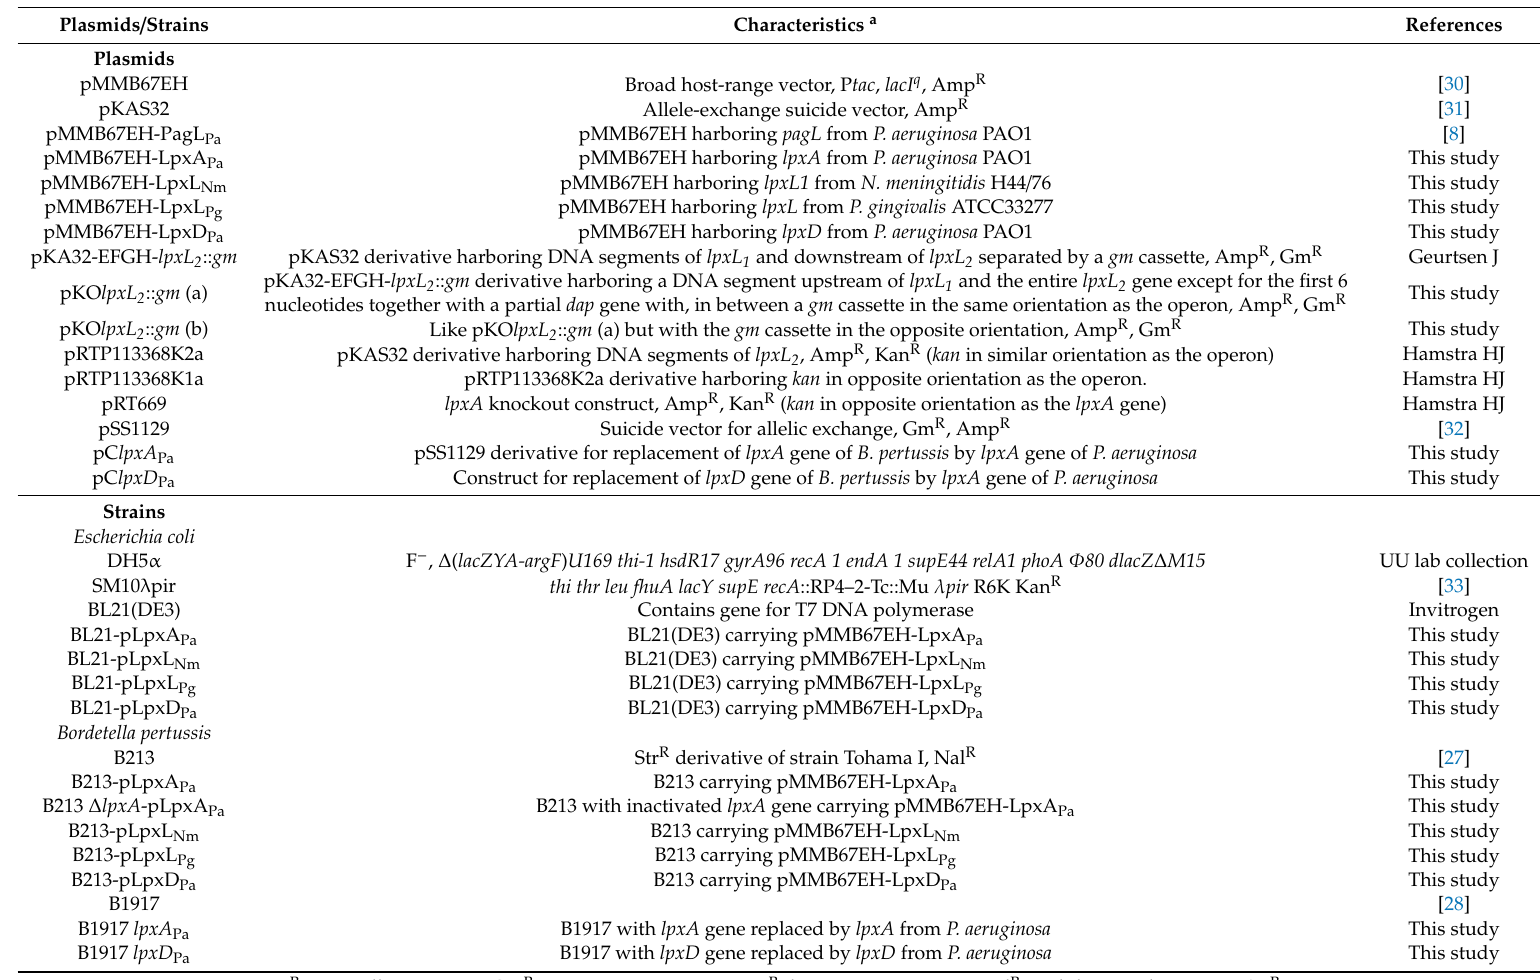
Table 1. Plasmids and strains used in this